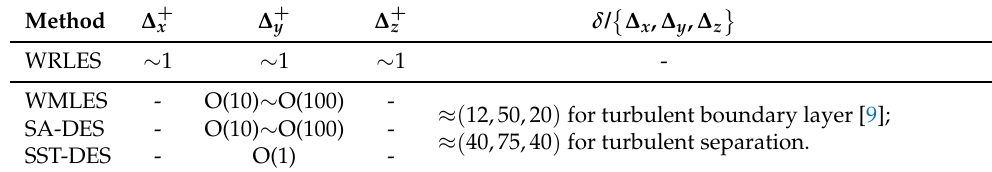
Table 7. Grid requirements for WMLES, SA-DES and SST-DES in OpenFOAM. Method